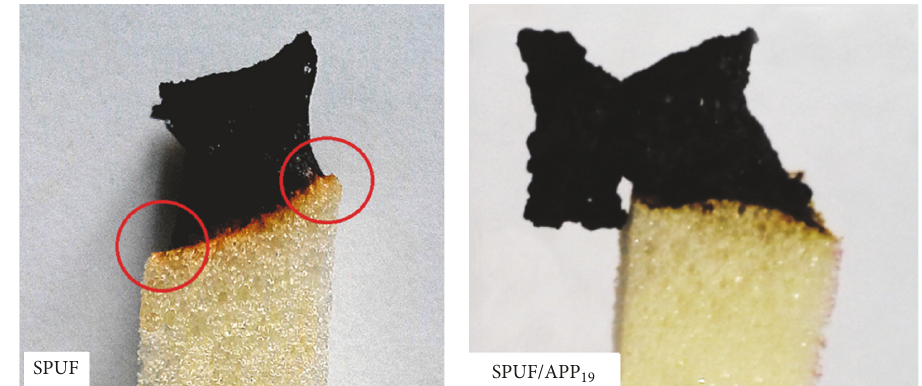
Figure 4: Digital photos of residual char.